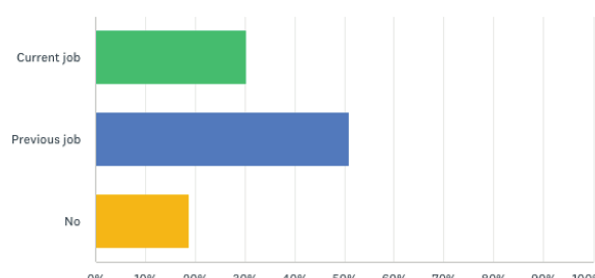
Figure 3. ‘How much ENT experience do you have?’